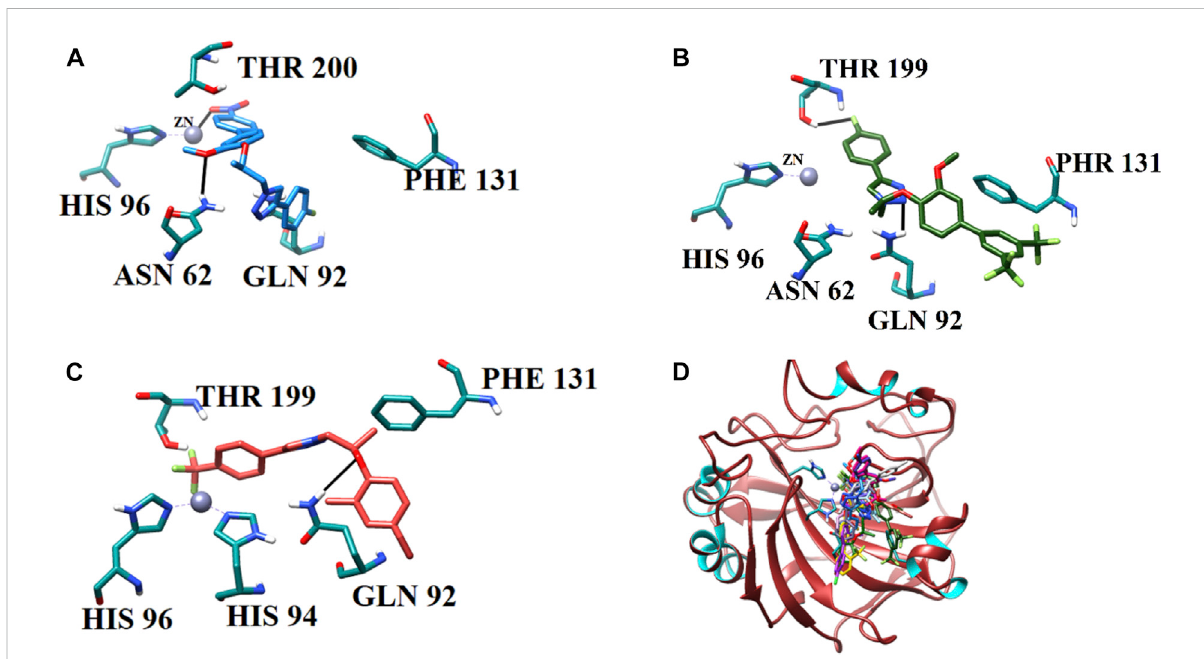
FIGURE 6 Binding orientations of (A) most active compound 9i (sky blue stick model), (B) moderate active 9m (green stick model), (C) least active 7b (salmonstickmodel),and (D) alltheactivecompounds(stickmodels)areshownintheactivesiteofhCA-II.Theactivesiteresiduesareshownincyan sticks, and H-bonds are depicted in black